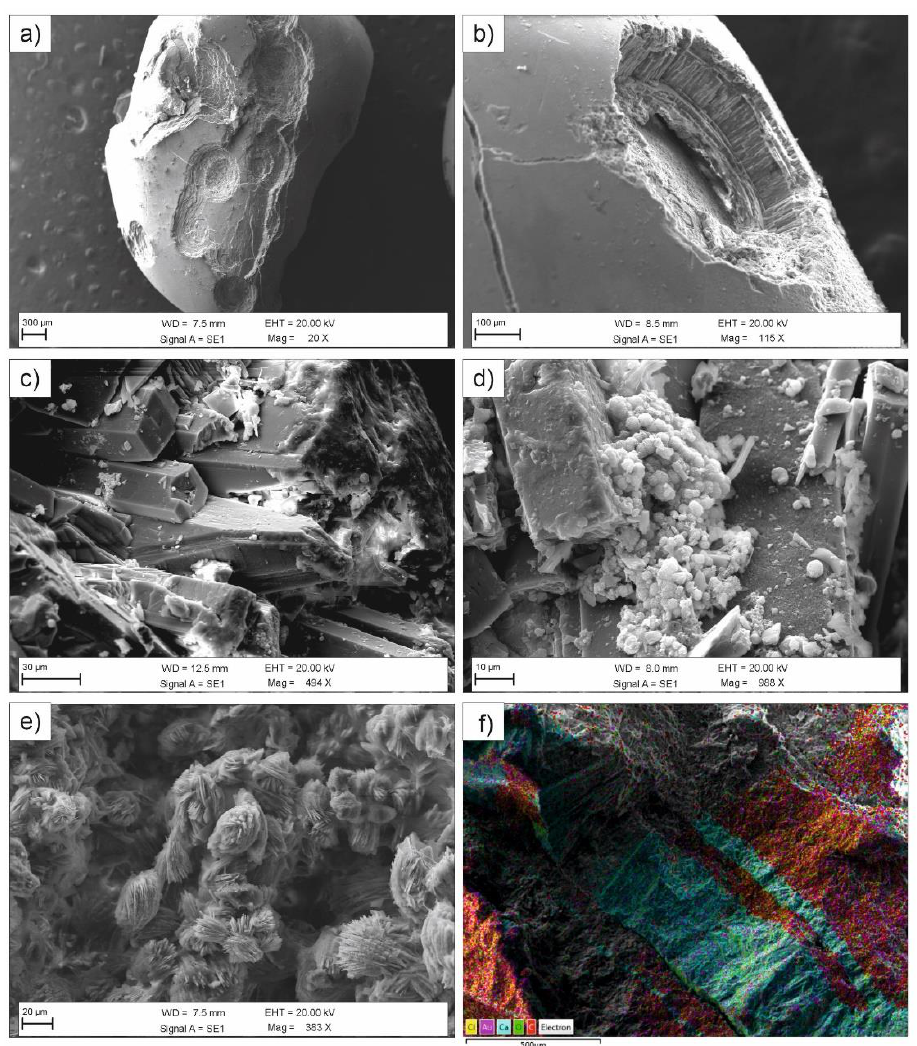
Figure 3. Secondary electron images of the examined calculi: ( a , b ) umbilicated surface of sample KS044 (subtype Ia); ( c ) prismatic crystals of brushite (subtype IVd) with ( d ) spheroidal inclusions of CaP stones in the porous system; ( e ) weddellite aggregates showing a “desert rose” shape in a mixed urinary stone (KS041, type VII); ( f ) distribution of Ca and C in alternated layers of uric acids and CaOx in sample KS039 (subtype IIIa/Ia).